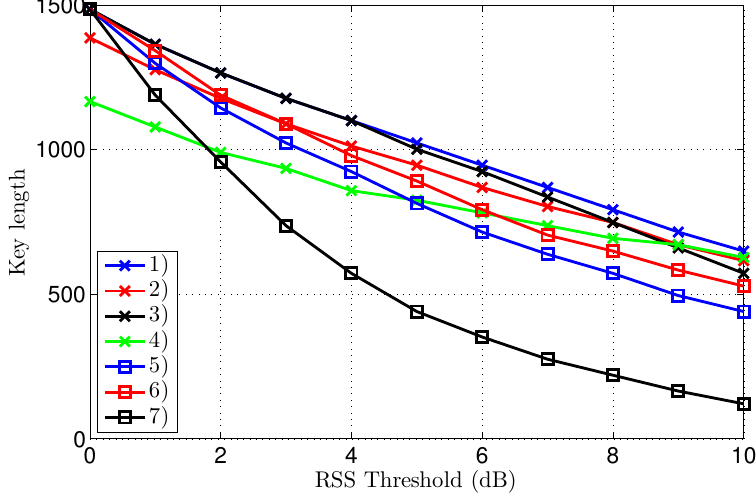
Figure 8. Key Error Rate after reconciliation for different threshold levels, for all